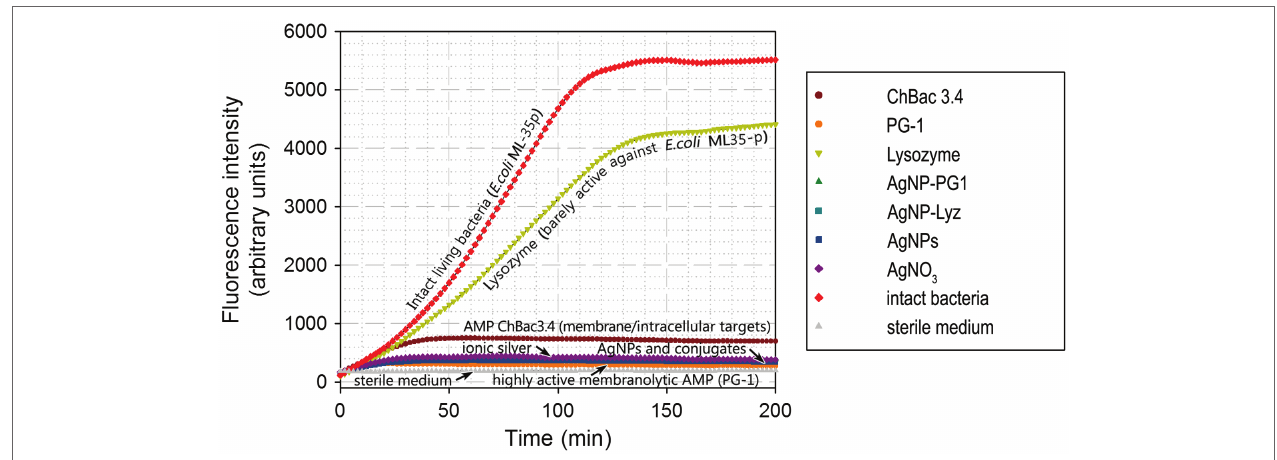
FIGURE 2 | Dynamics of E. coli ML-35p metabolic activity inhibition by AgNP-AMP/AP conjugates. Effects were compared to those of antimicrobial peptides and proteins (AMPs and APs), gelatin-only coated silver nanoparticles (AgNPs) and ionic silver (AgNO 3 ). An actively metabolizing cell supplies the redox-sensitive marker resazurin with metabolic reducing agents, turning it into the fluorescent resorufin. An increase in fluorescence intensity thus indicates actively metabolizing bacteria. The tested concentration of the antimicrobials was equal to 4 × MIC (minimal inhibitory concentration); typical curves are